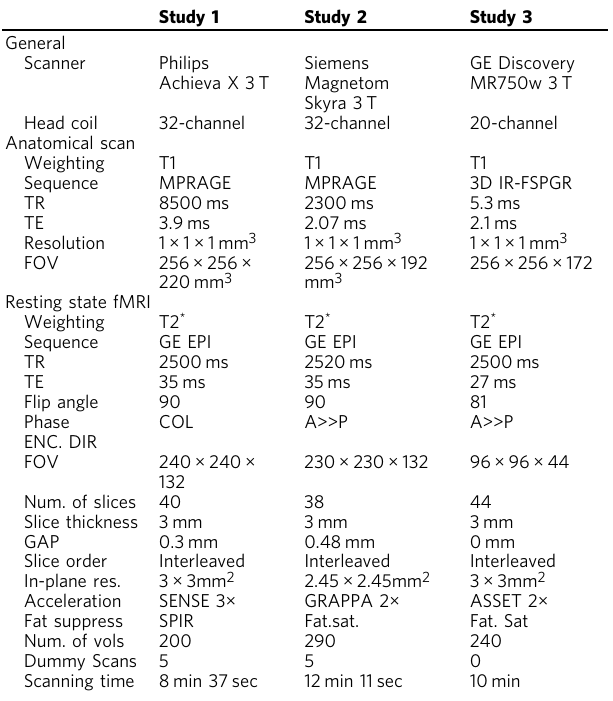
Table 4 MRI scanner and sequence parameters for each